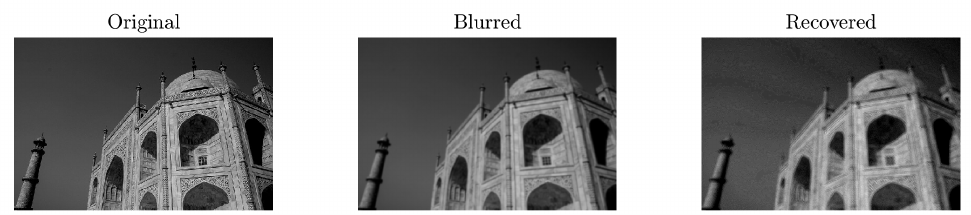
Figure 8. Images containing fine details could not be deblurred by the first independent component analysis method.